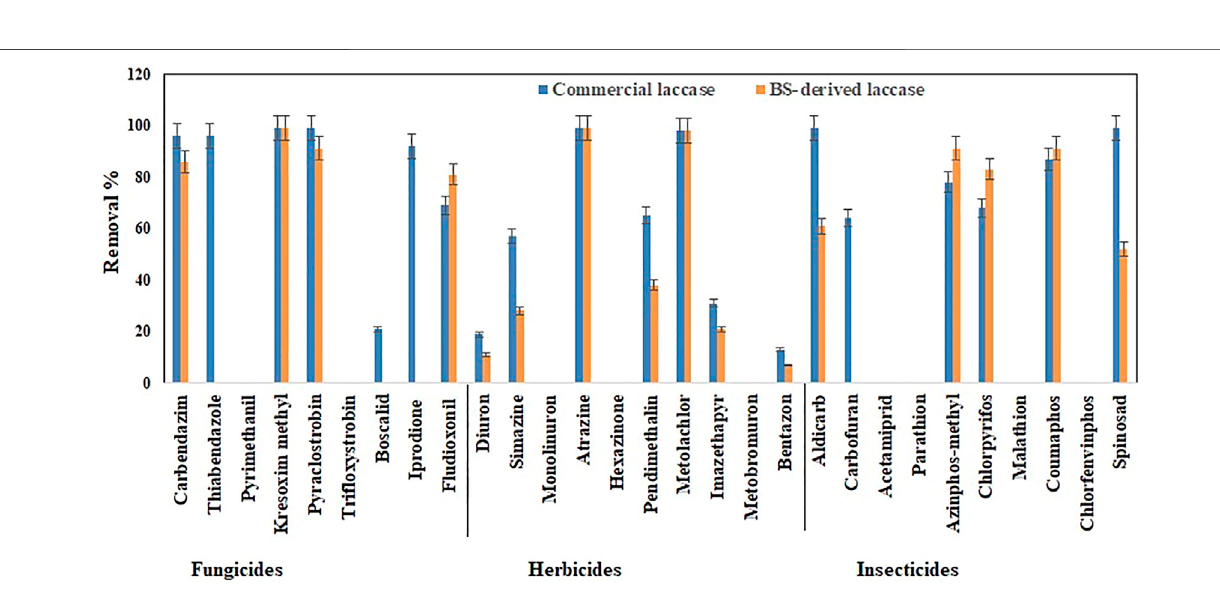
FIGURE 5 | Bio-catalytic removal of 29 pesticide compounds treated as a cocktail mixture in aqueous solution by Pleurotus dryinus laccase derived from BS and commercial laccase during 24 h. The experiments were done in triplicate at pH 7.0 and 20 ° C, and the error bar represents the percentage error at 5% level of signi fi